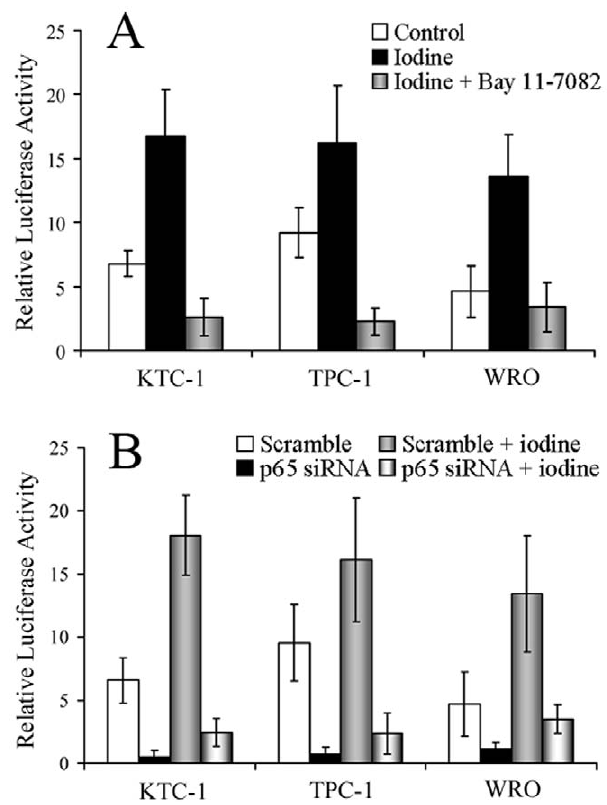
Figure 3. Repoter gene activity changes after different treatments. ( A ) DTC cells were transfected with pNF- k B-luc, and pRL-SV40 served as an internal control. After 12 hours, cells were left untreated or incubated with 131 I (20 MBq/ml), or in combination with Bay 11-7082 (5 m mol/L) for 6 hours. NF- k B activation was detected by luciferase reporter assay. ( B ) At 24 hours after transfection with scrambled oligonucleotides or p65 siRNA, cells were co-transfected with pNF- k B-luc and pRL-SV40. After 12 hours, cells were left untreated or treated with 131 I (20 MBq/ml) for 6 hours. Then luciferase reporter assay was performed. Similar results were obtained in three indepen-